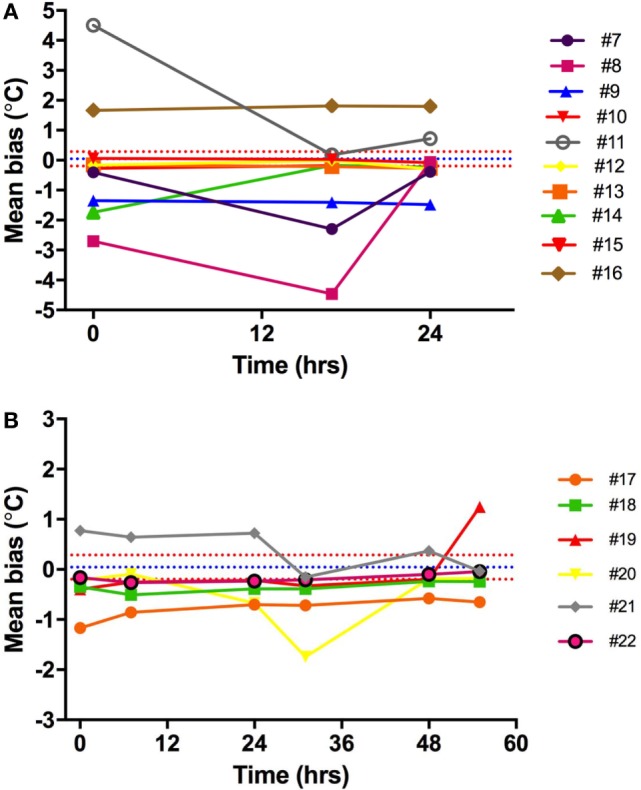
Capsule vs. Hg thermometer bias. Mean bias for temperature reading of each capsule vs. Hg thermometer at different time points over 24 h (A) or 55 h (B). Different colored lines represent different capsules. Blue and red dashed lines are the mean bias and limits of agreement, respectively, indicating the potential variability of investigator (parallax error) for reading the Hg thermometer.